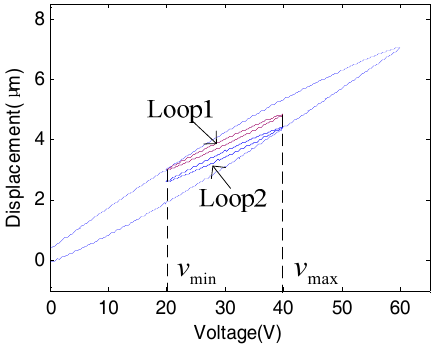
Figure 6. Congruency property of the hysteresis.